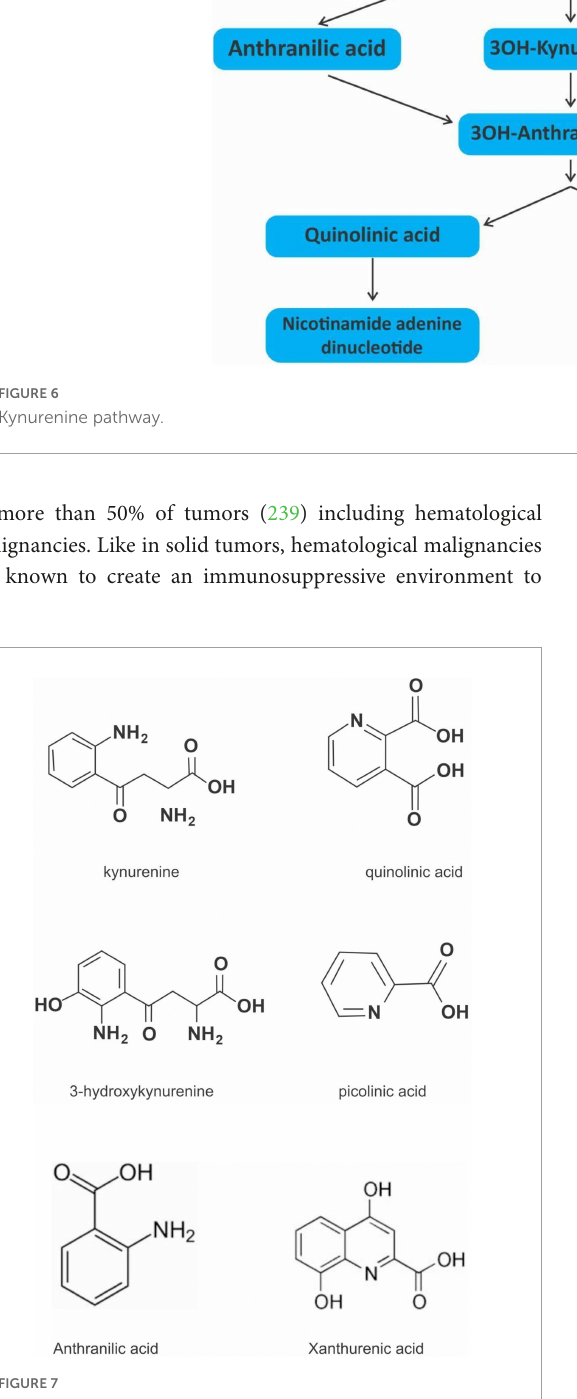
FIGURE7 Cheemical structure of kynurenine pathway